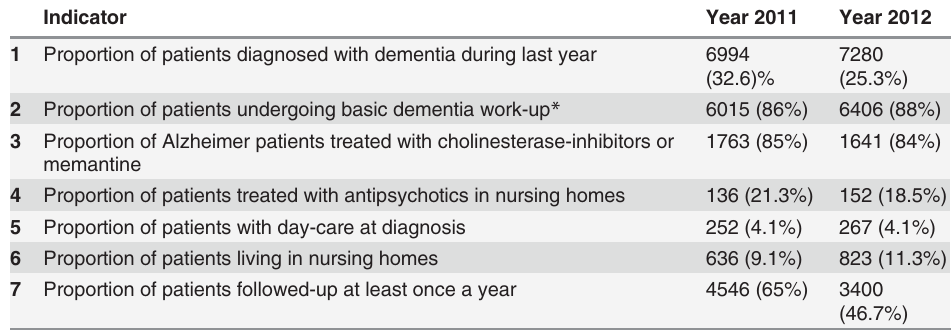
Table 3. Data from the SveDem population on quality indicators de fi ned by the Swedish national guidelines for dementia care and treatment.